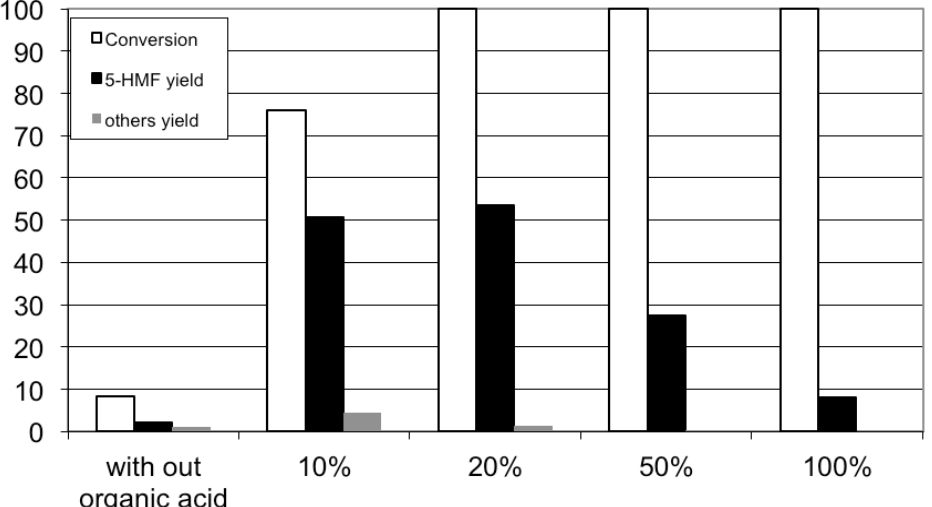
Figure 14. Fructose dehydration in 5-HMF obtained in formic acid aqueous solutions of various compositions in the absence of added solid